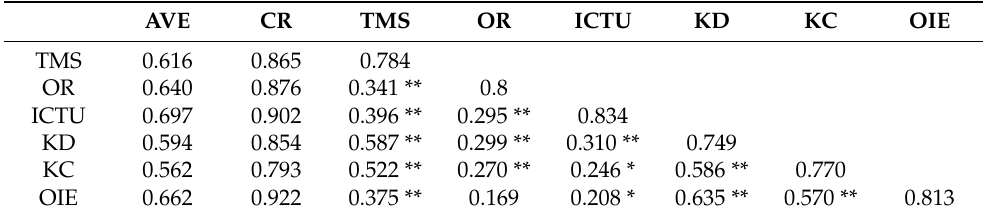
Table 1. Discriminant validity.